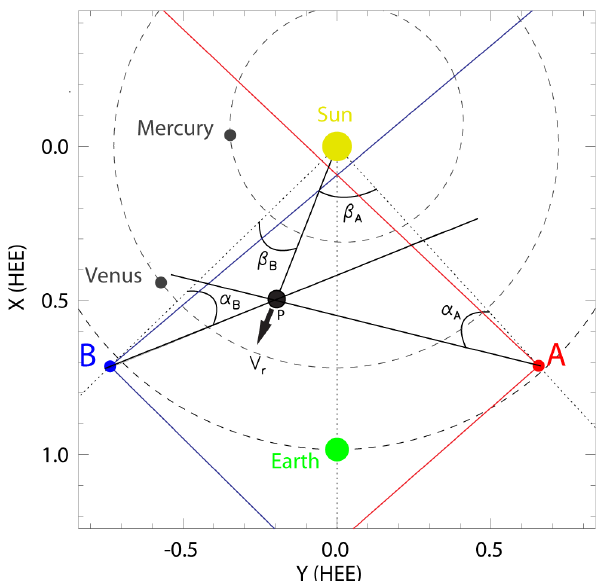
Fig. 1. The locations of STEREO A(head: red) and B(ehind: blue) in the ecliptic plane on 1 January 2009, illustrating the extent of the HI field of view on each spacecraft. The elongation of P, which cor- responds to a solar transient moving with velocity V r . at an angle β A ( β B ) with respect to STEREO A (B), is α A and α B for space- craft A and B,